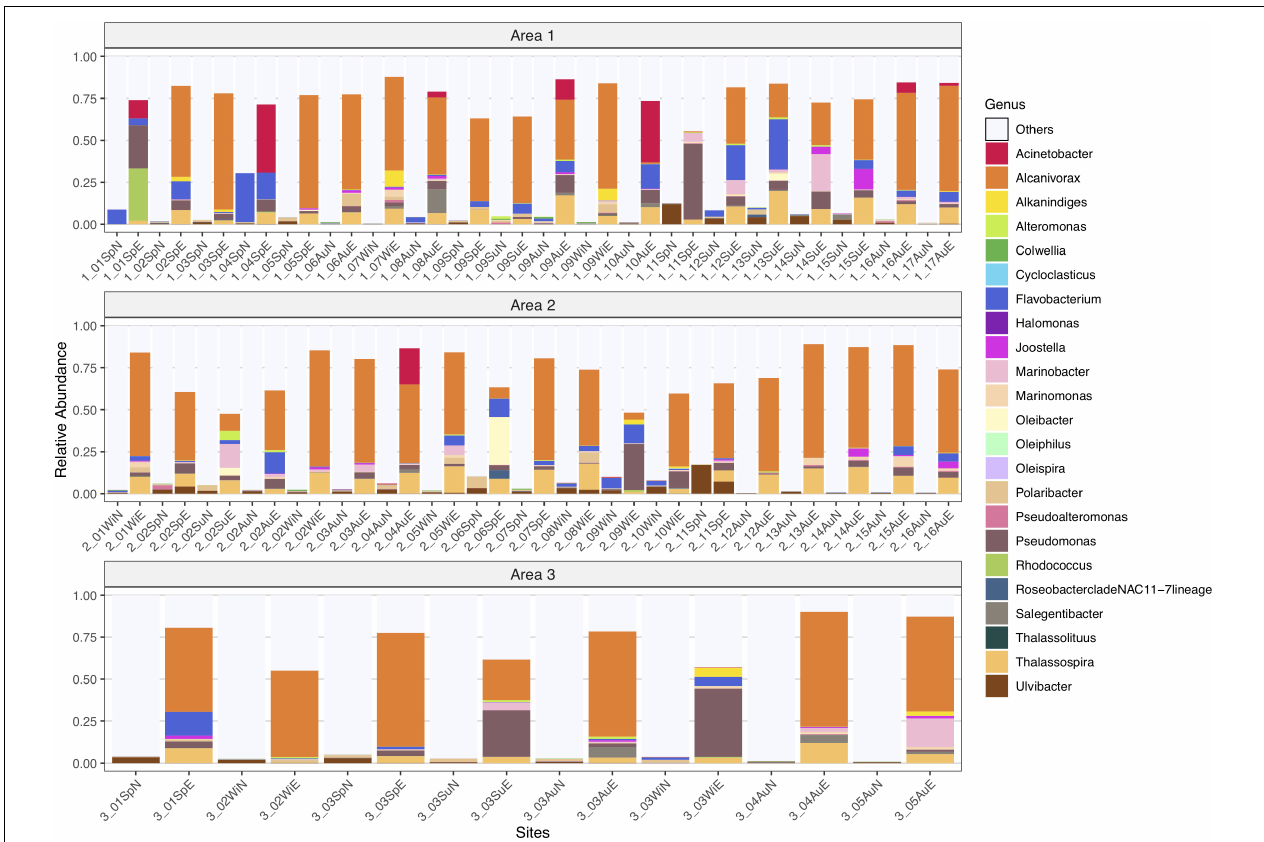
FIGURE 7 | Taxonomic profile of relative abundances of ASVs for natural prokaryotic communities and oil-enriched communities, in 47 sampled sites, distributed per Area (1, 2, and 3), for 23 genera known to degrade petroleum